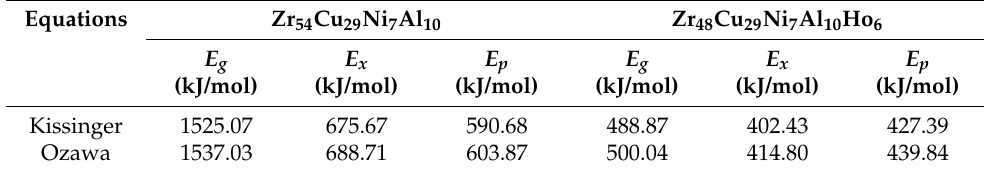
Figure 5. Kissinger and Ozawa plots of ( a , c ) Zr54 BMG and ( b , d ) Zr48Ho6 BMG. Table 3. Activation energies obtained by two equations for Zr54 BMG and Zr48Ho6 BMG.